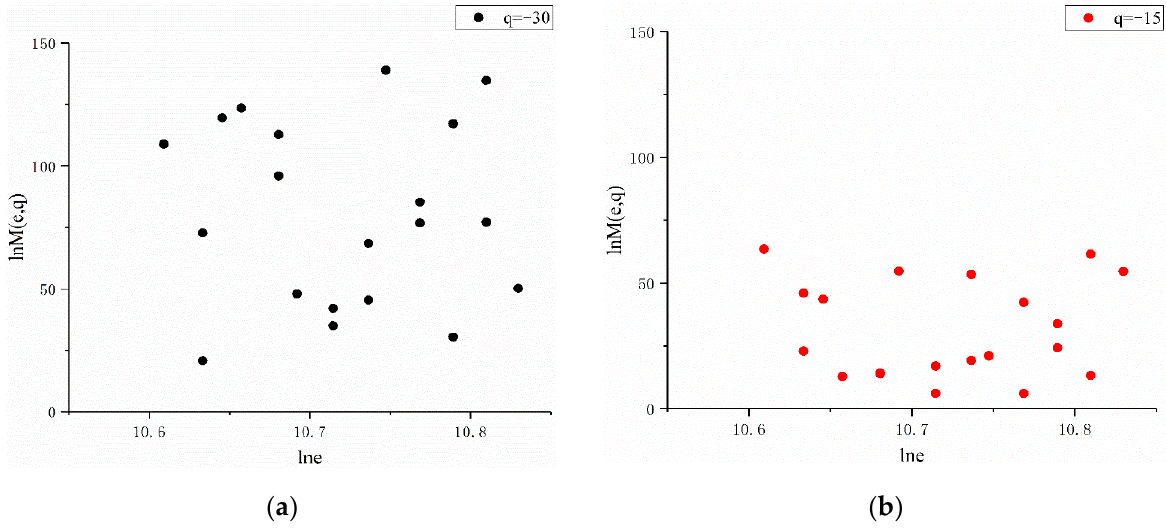
Figure A2. The relationship of ln M ( e , q ) and ln e in the Fenhe River Basin. ( a ) The relationship of ln M ( e , q ) and ln e when e is [40,000, 50,000] and q is − 30; ( b ) The relationship of ln M ( e , q ) and ln e when e is [40,000, 50,000] and q is − 15.